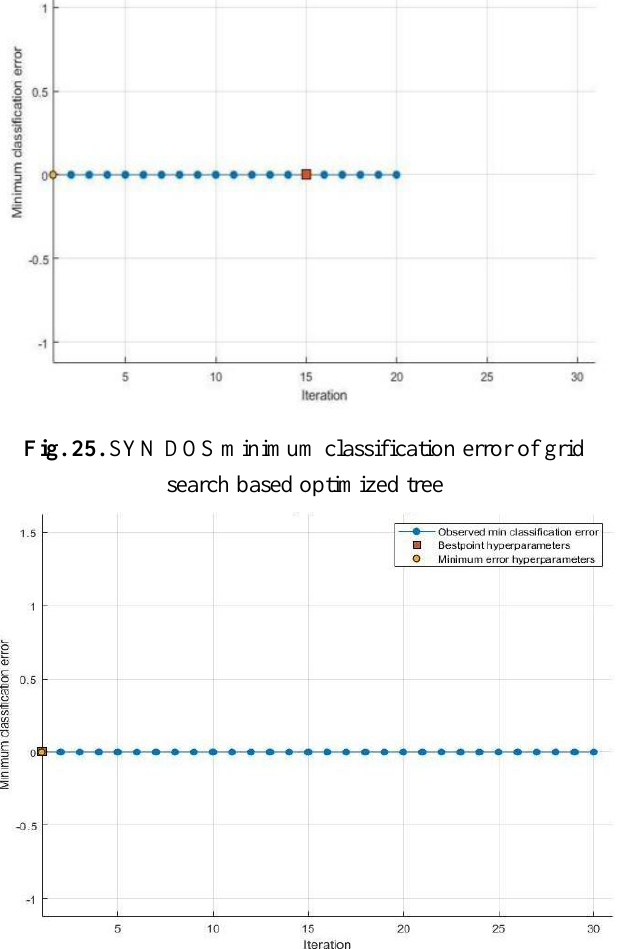
Fig. 26. SYN DOS minimum classification error of random search based optimized tree